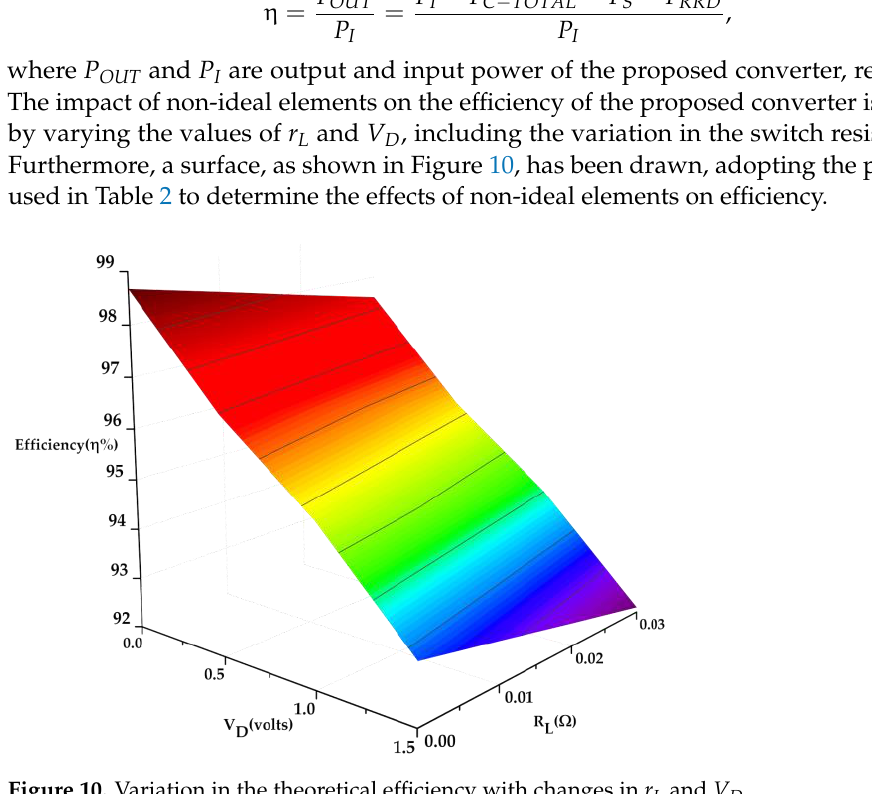
Figure 10. Variation in the theoretical efficiency with changes in r L and V D.